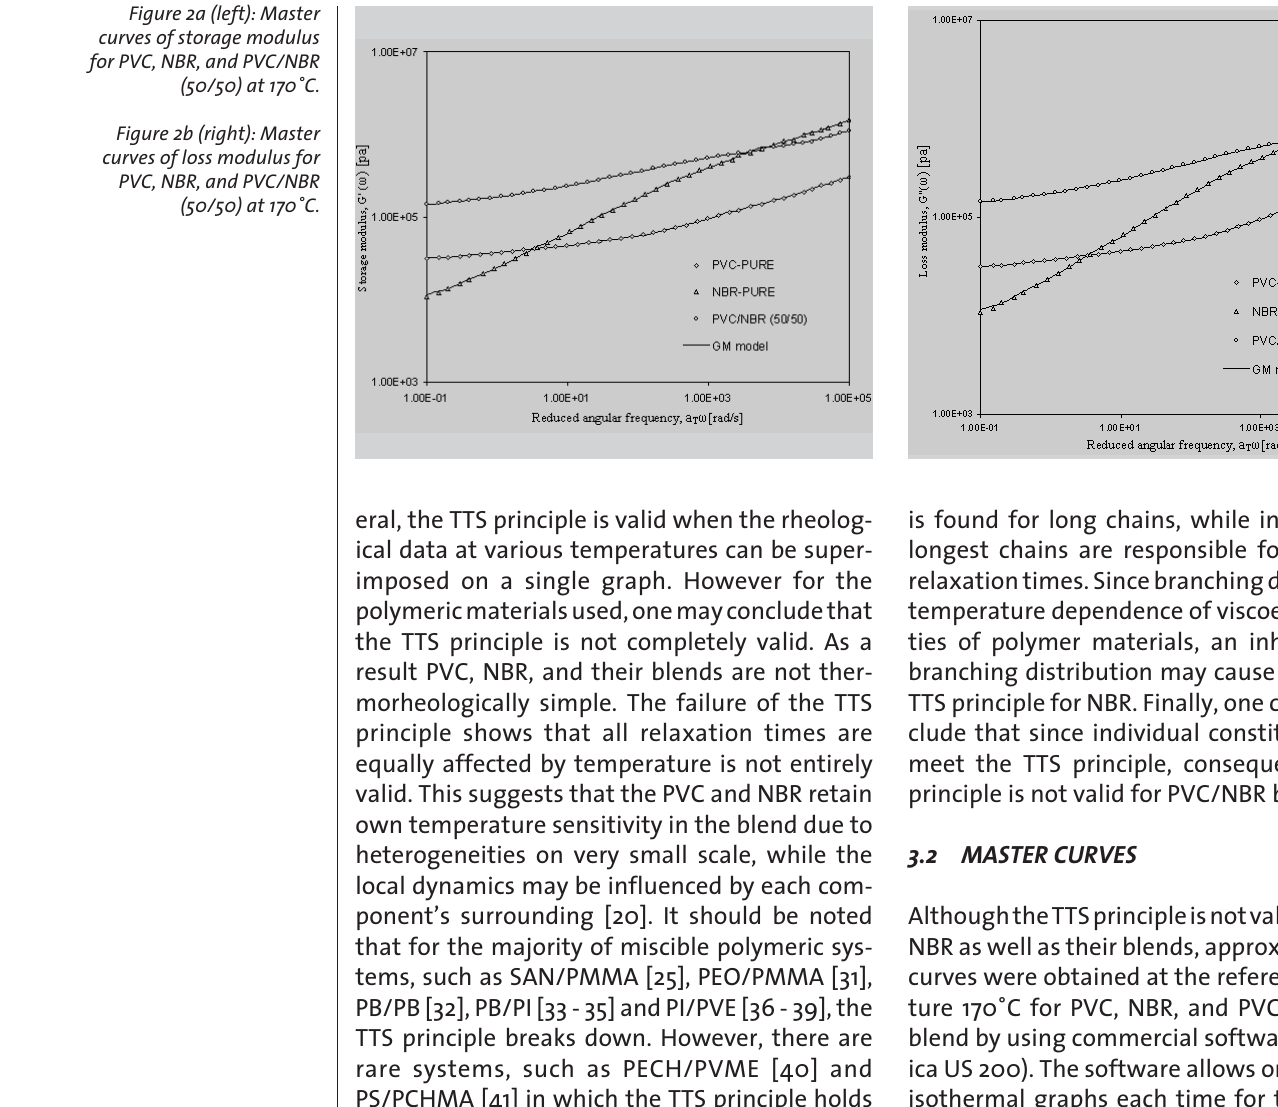
Figure 2a (left): Master curves of storage modulus for PVC, NBR, and PVC/NBR (50/50) at 170˚C. Figure 2b (right): Master curves of loss modulus for PVC, NBR, and PVC/NBR (50/50) at